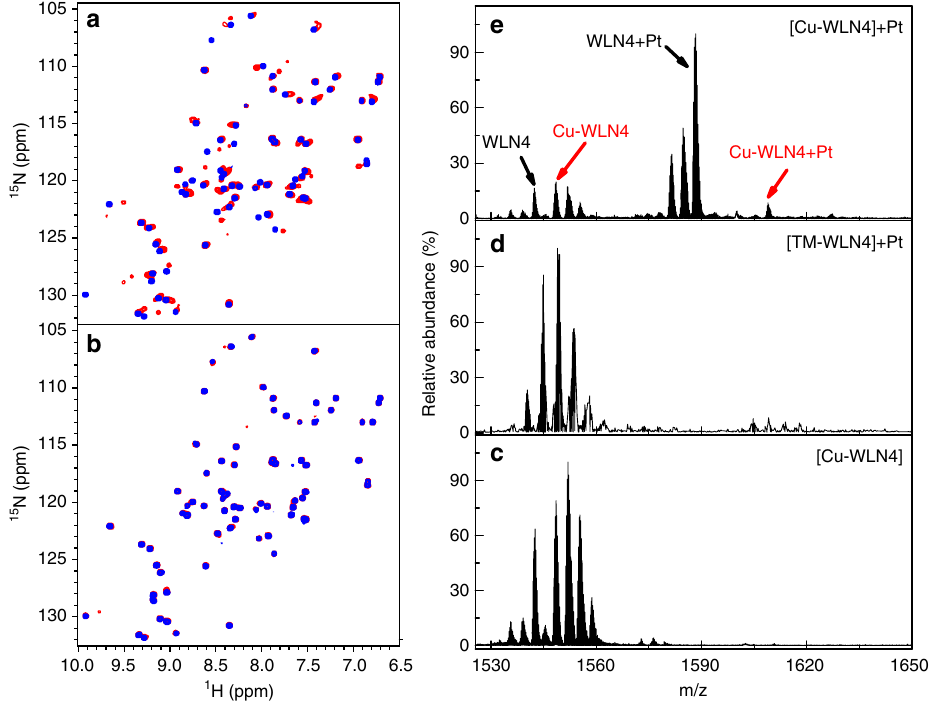
Fig. 3 The effect of TM on platination of WLN4. a , b 1 H- 15 N HSQC NMR spectra. a Superposition of spectra of apo-WLN4 before (blue) and after (red) the reaction of cisplatin. b Superposition of spectra of TM-WLN4 before (blue) and after (red) reaction of cisplatin. c – e ESI-MS spectra. c Cu-WLN4; d incubation of TM/Cu-WLN4 adducts with cisplatin; e incubation of Cu-WLN4 with cisplatin. The reaction was conducted on 50 μ M protein with 150 μ M cisplatin at 25 °C for 8 h. The selected m / z region shows + 5 charged peaks. The peaks are shown in a cluster due to the binding of different number of NH 4 + ions since NH 4 OAc was used. The assignment of peaks is given in Supplementary Fig. 8 and Supplementary Table